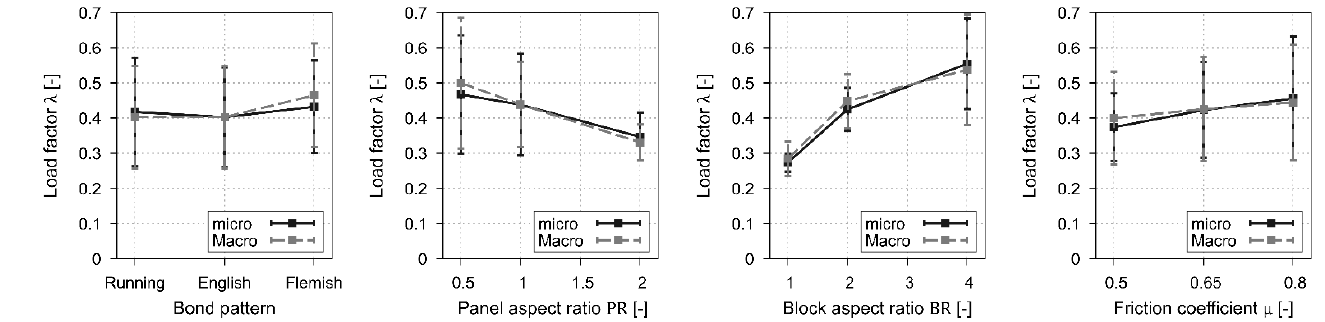
Figure 3. Linear interaction: micro and macro LA.